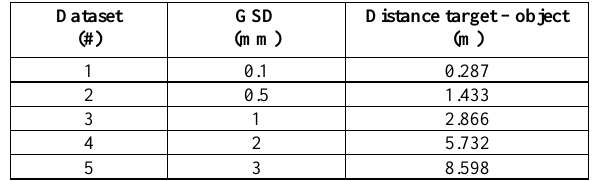
Table 4. Relation GSD Vs Flight height